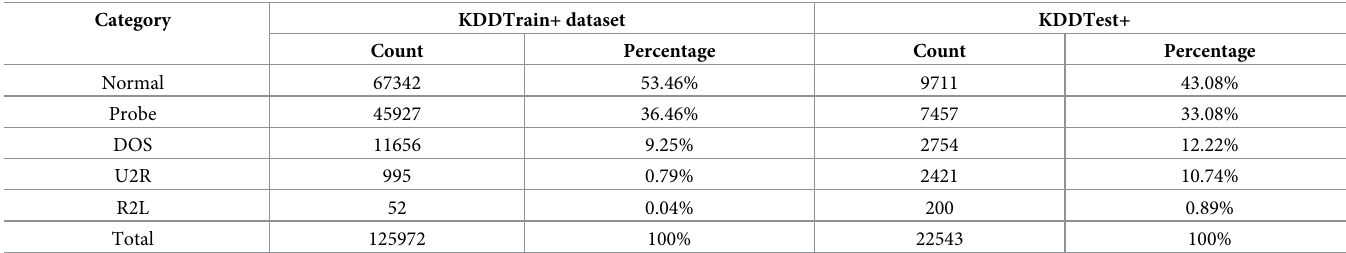
Table 1. Distribution of five major categories behaviours of KDDTrain+ and